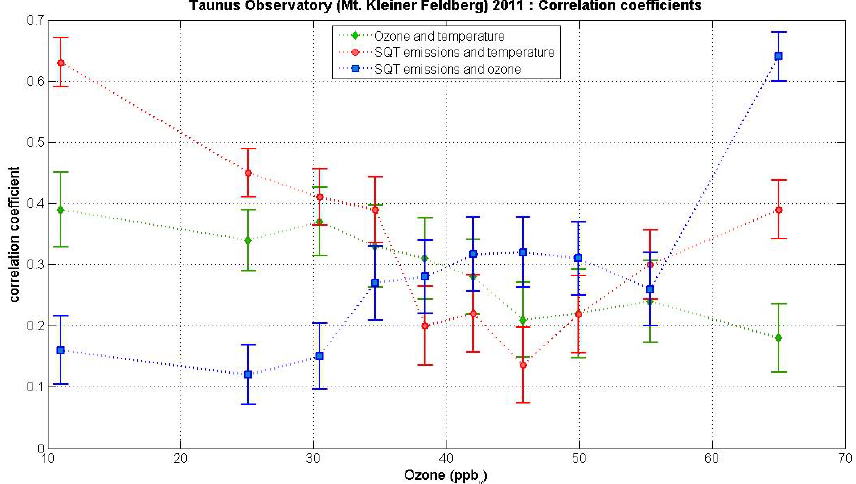
Fig. 4. Correlation coefficients for temperature and ozone calculated individually for ten different ozone regimes. In moderately or less polluted atmospheric conditions SQT emissions were better correlated with temperature, while in more polluted atmospheric conditions the emissions were better correlated with ambient ozone mixing ratios, indicating a critical threshold in the parameter that is driving the emissions. The smaller correlation between ambient ozone concentrations and temperature is observed in higher ozone regimes, indicating a stress due to ozone only not because of heat stress.